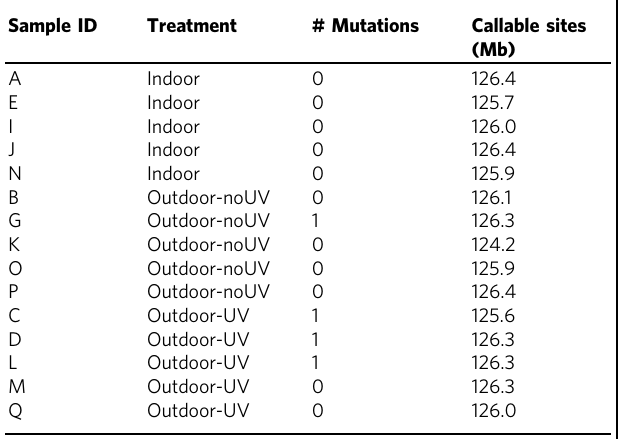
Table 1 Summary of the sequencing data and detected mutations Sample